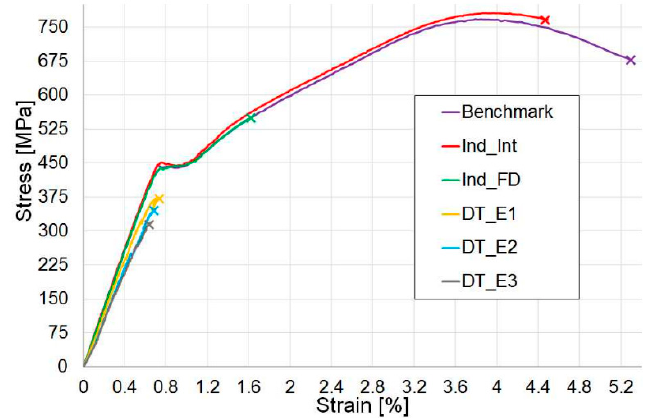
Figure 12. Tensile stress–strain curves: a comparison. Benchmark (undamaged specimens), pre-Indented Fully Damaged (Ind_FD) and pre-Indented Interrupted (Ind_Int) specimens and samples pre-impacted at 2.2 J (DT_E1), 3.2 J (DT_E2) and 4.2 J (DT_E3).